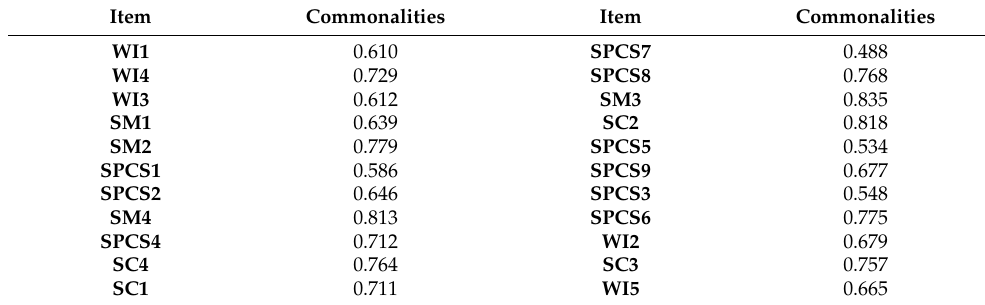
Table 2. Communalities of 22 CSF items.